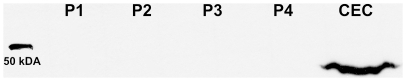
Western blot showing the negative cellular contamination of the tear samples.Four differing tear fluid pools P1–P4 were applied into the wells of SDS-PAGE gel. Equal amount of protein was loaded in each well. CEC, corneal epithelial cell lysate.